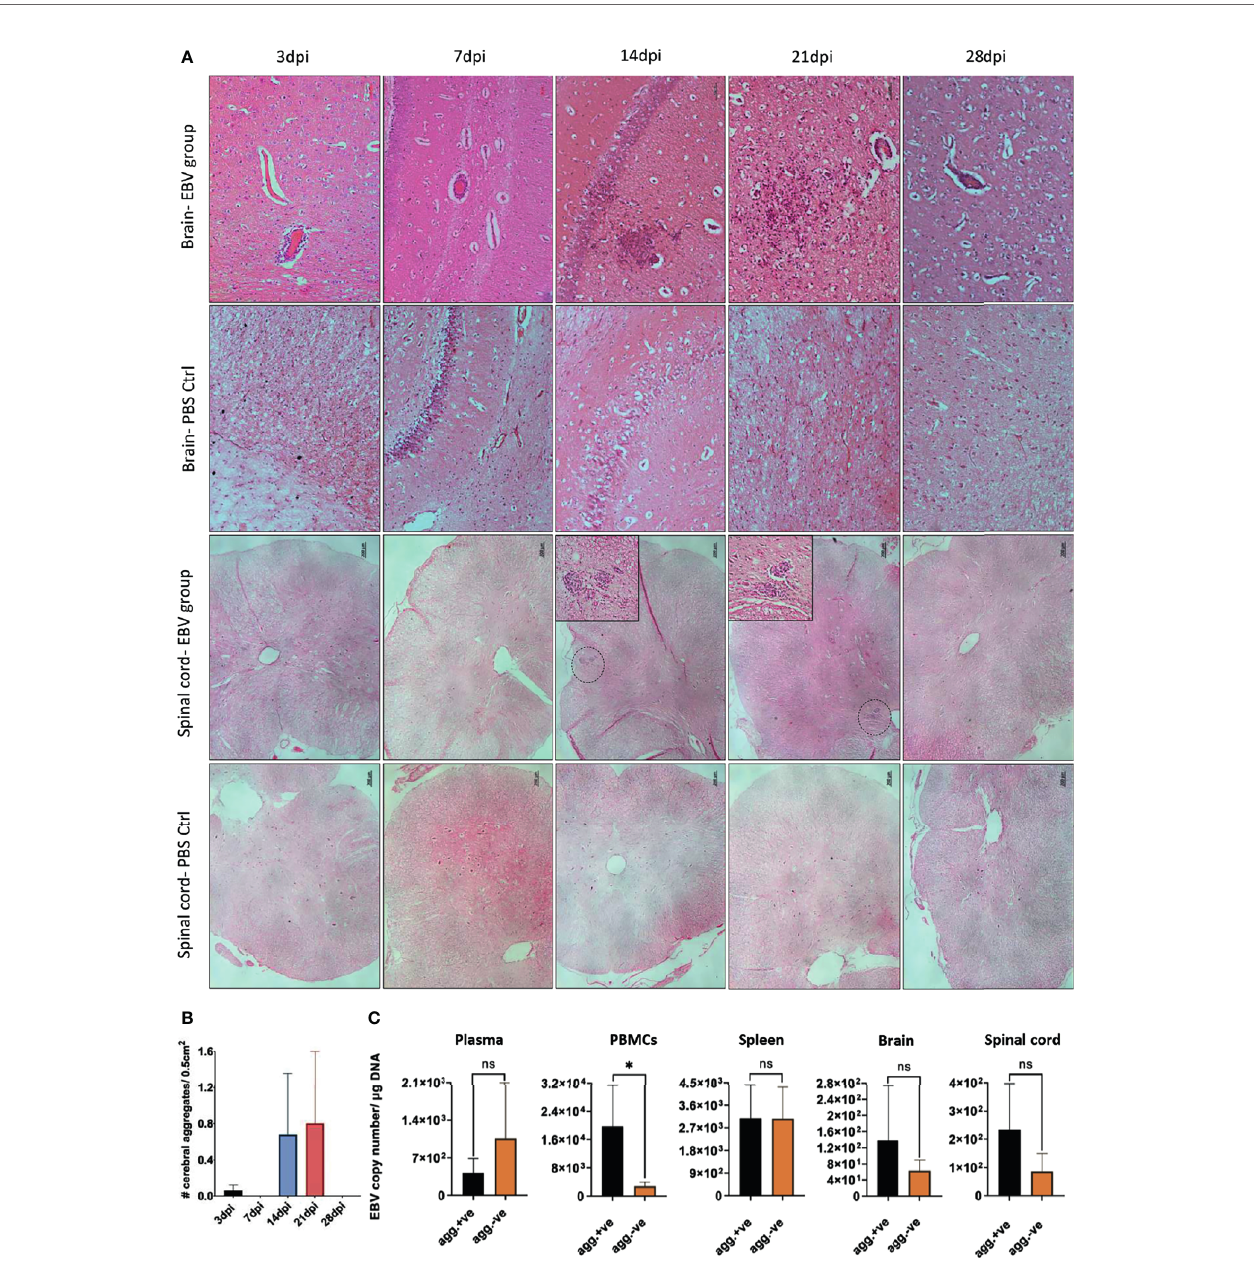
FIGURE 8 | CNS aggregate formation peaks at 14 and 21dpi. (A) Representative images of H&E staining of coronal brain sections (scale bar=50µm) and cross sections of spinal cord (scale bar=200µm) from EBV group and PBS control group (PBS ctrl) sacri fi ced at 3, 7, 14, 21 and 28dpi. (B) Quanti fi cation of cell aggregates in the brain. Aggregates were counted in one every 50 5µm-sections over a span of ~1000 brain sections from EBV infected animals sacri fi ced at 3, 7, 14, 21 and 28dpi ( n =3 rabbits/time-point). Number of cell aggregates per 0.5cm 2 are displayed as mean ± SEM. Comparisons were made using the non-parametric Kruskal-Wallis test. (C) Comparison of EBV load in plasma, PBMCs, spleen, brain and spinal cord of animals with CNS aggregates and those without using two- tailed unpaired t test and Mann-Whitney test. ns: p > 0.05, * p ≤